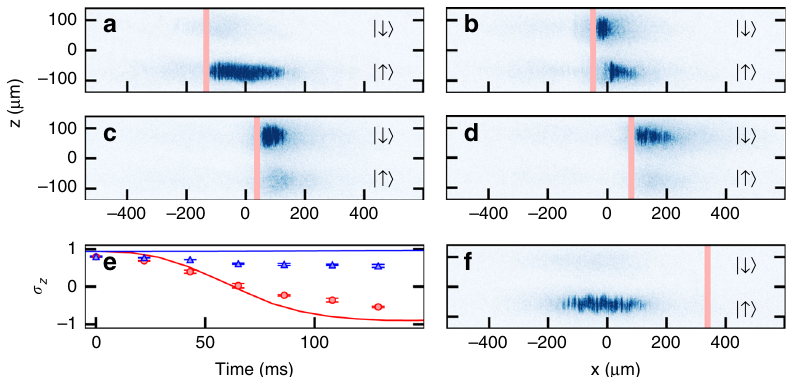
¼ 2 mms (cid:3) 1 . Fig. 3 Progression of dynamics during a barrier sweep. a – d The potential barrier, represented by the red vertical line, moves to the right at v b Atoms initially occupying the | ↑ 〉 state are transferred to the | ↓ 〉 state as the sweep progresses. Experimental absorption images are taken after 10.1 ms time-of- fl ight, during which a Stern – Gerlach imaging technique is used to vertically separate the individual spin states. Images correspond to times a t = 22 ms, b t = 87 ms, c t = 130 ms, and d t = 195 ms into the sweep. e Spin polarization during the sweep. Data points are mean ± s.d. for fi ve experimental ¼ þ 2 mms (cid:3) 1 (red circles) and v ¼ (cid:3) 2 mms (cid:3) 1 (blue triangles). Red and blue solid curves are runs at each measured time for a barrier moving at v b b numerical Gross – Piteavskii equation (GPE) simulations for right and left moving barriers, respectively. f BEC remains in the | ↑ 〉 state after a + 15 mm s − 1 full barrier